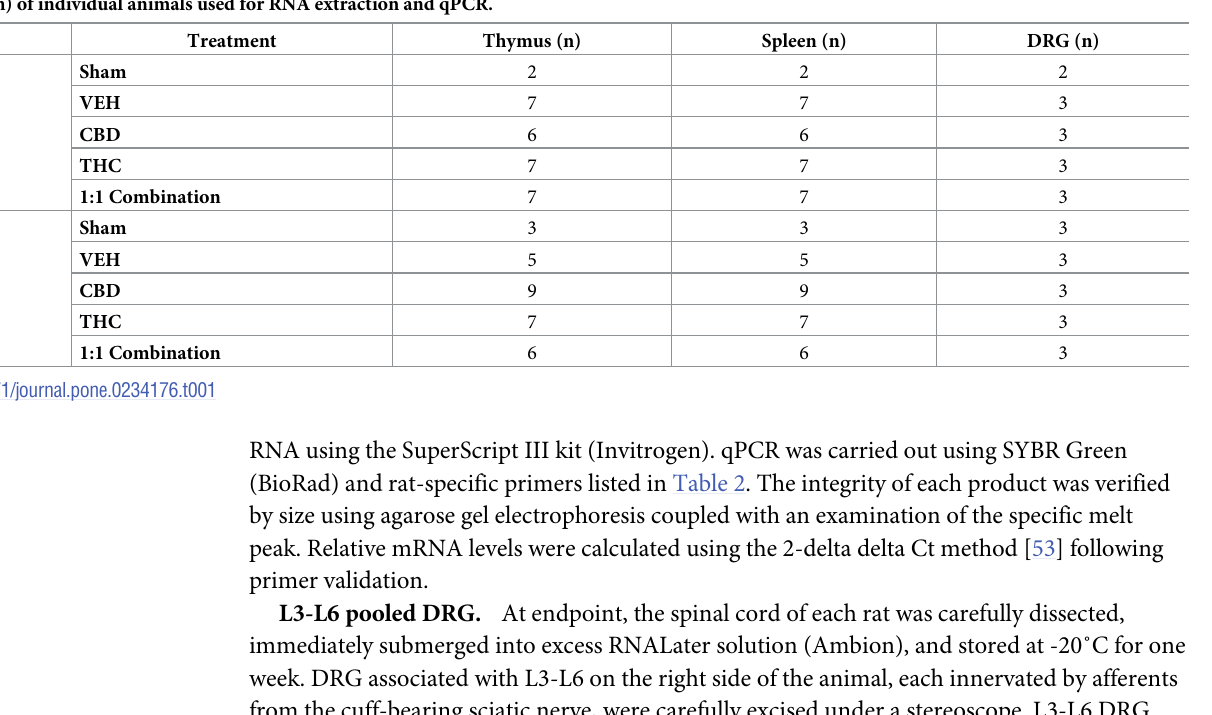
Table 1. Number (n) of individual animals used for RNA extraction and qPCR.